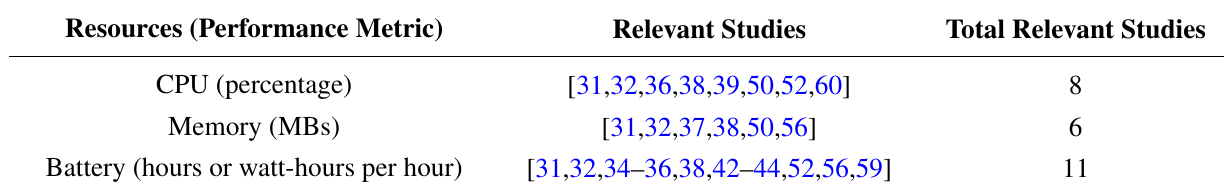
Table 6. Studies with resource consumption